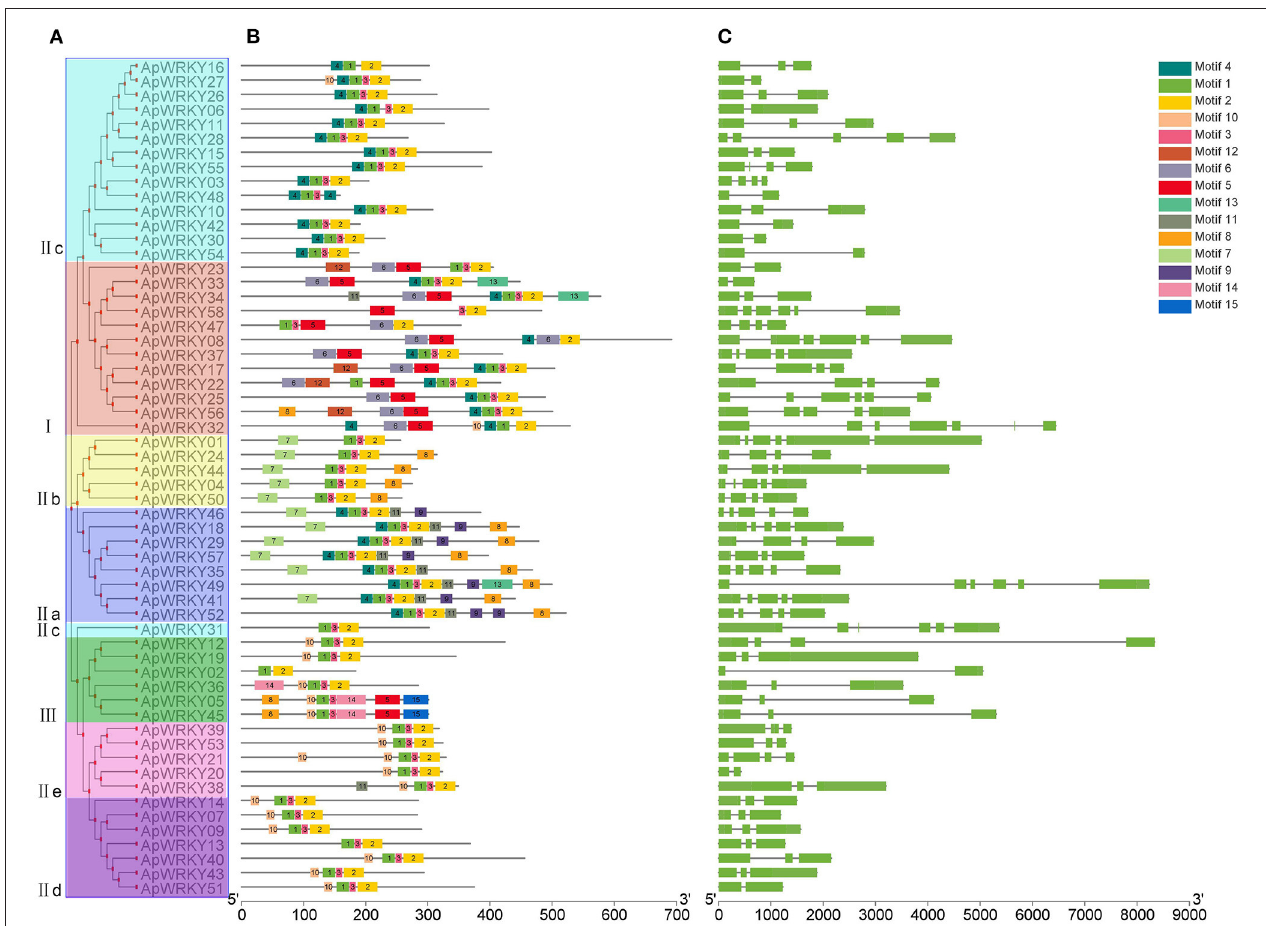
FIGURE 4 | The gene structure and the distribution of conserved motifs within each ApWRKY in A. paniculata . (A) Phylogenetic tree of ApWRKY proteins. (B) The distribution of conserved motifs within each ApWRKY protein. (C) The gene structures of ApWRKYs . Exons were represented by green boxes and introns were represented by black